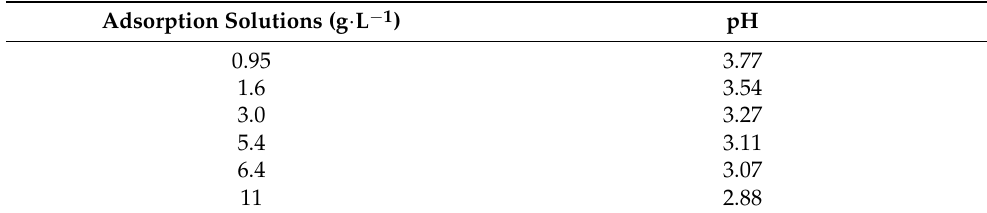
Table 2. pH values of the solutions before